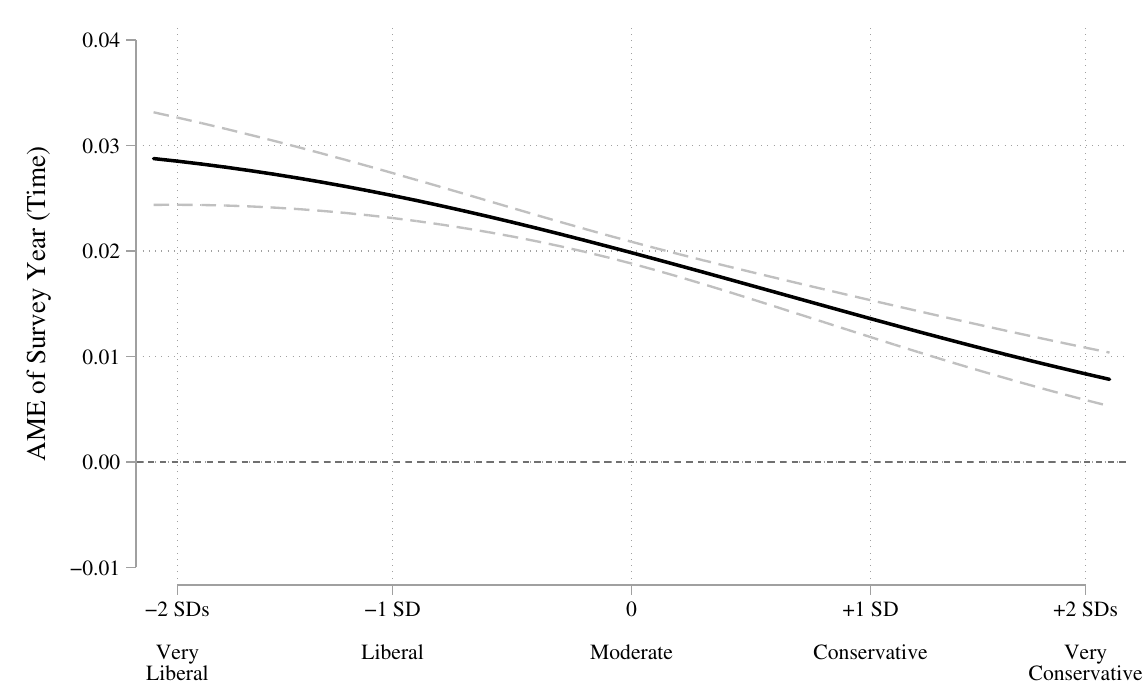
Figure 17: Average marginal effect of time (GSS survey year) on the probability of viewing same-sex relation- ships as acceptable across political